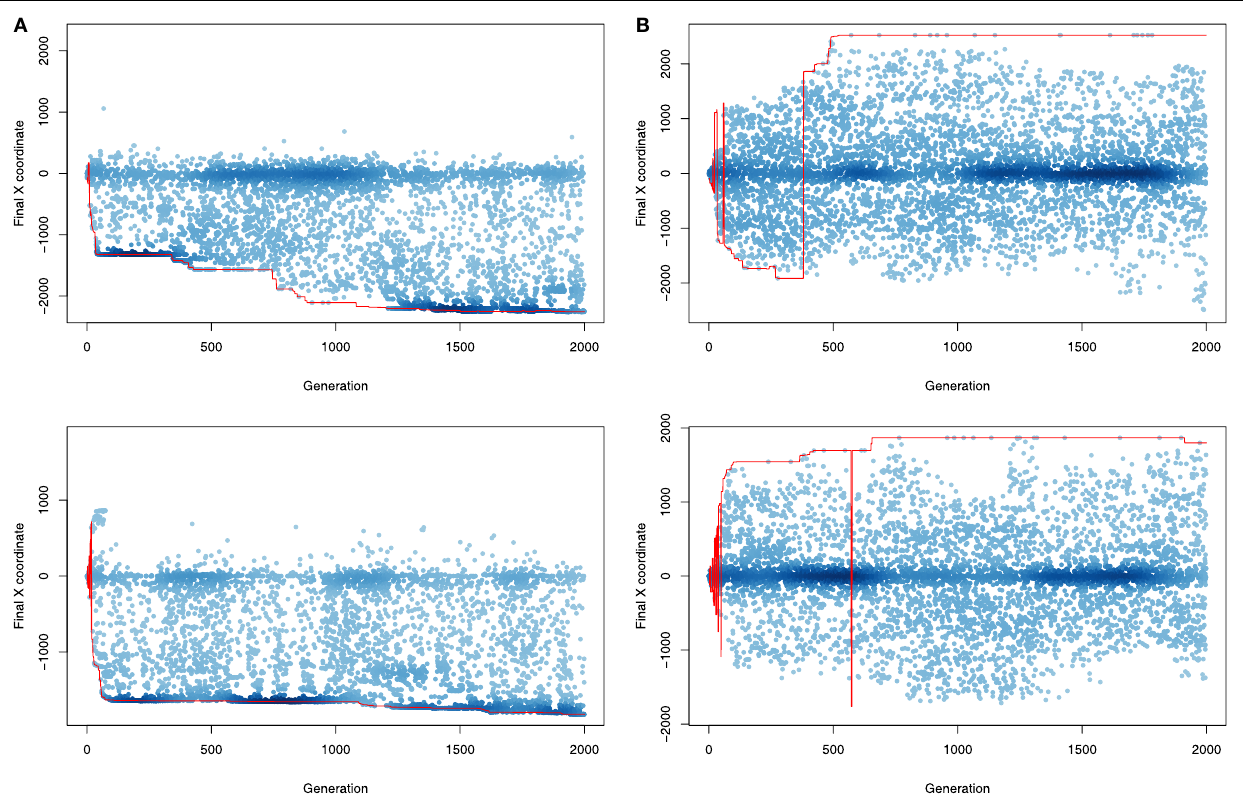
FIGURE 9 | Evolution of terrestrial animats: comparison of phenotype space coverage over evolutionary time when evolving with two search algorithms in experiments with oscillation-driven actuation (see Figure 6B for corresponding fitness plots) . The top row corresponds to the best run in each type of experiment, and the bottom row corresponds to the run that resulted in the median quality individual. Each point in a plot represents the final position of an individual who was evaluated during a given evolutionary run (a randomly chosen 1% individuals is shown). Color intensity corresponds to points density. The line connects points corresponding to the best individual (in terms of objective fitness value) in every generation. (A) NEAT search, (B) novelty search.